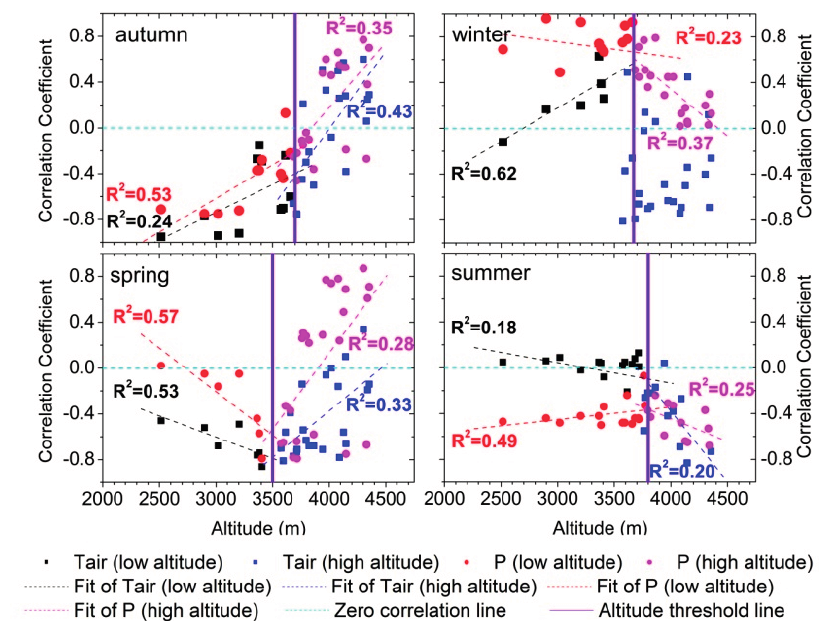
Figure 8. Altitude effects on correlation coefficients between climate factors (air temperature (T air ) and precipitation (P)). T air and P at low altitude (black and red) and high altitude (blue and pink) are labeled with different colors, respectively. The purple solid line defines the threshold altitude in each season. The cyan dashed line represents the correlation coefficient of